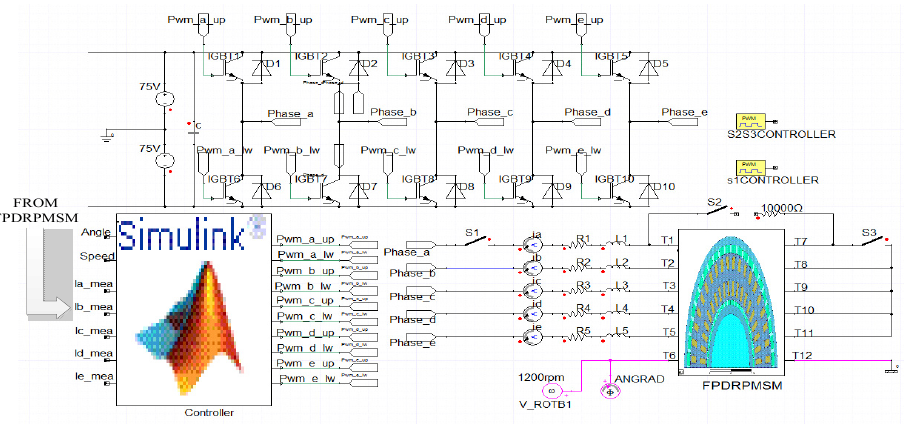
Figure 31. The main driver circuit in Simplorer.